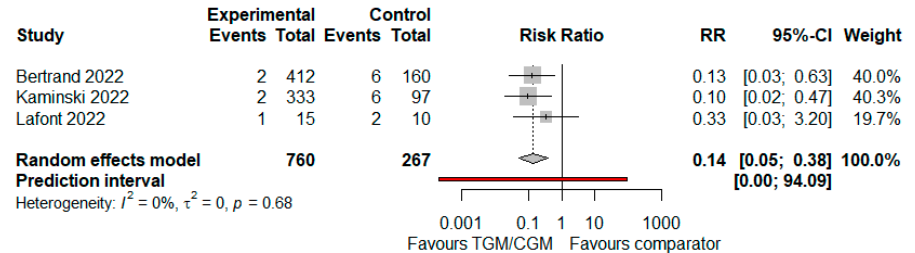
Figure 7. Rate of ICU admission (TGM/CGM vs. comparator). CI, confidence interval; RR, risk ratio; TGM/CGM, tixagevimab/cilgavimab.